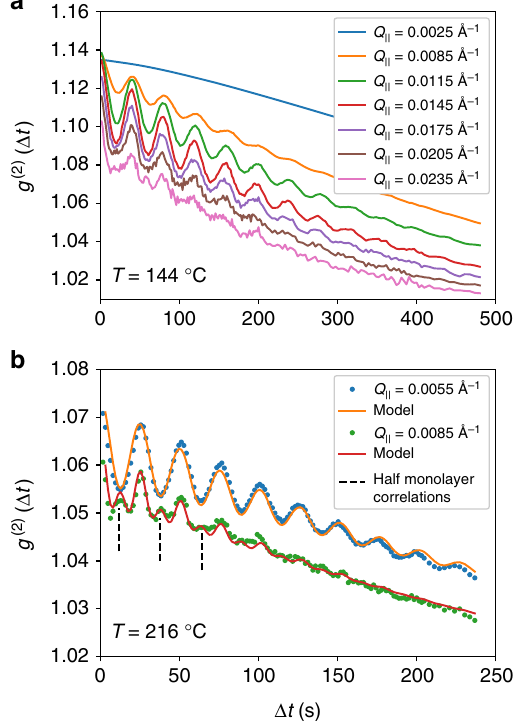
Fig. 3 Autocorrelations during steady-state deposition. a Growth at 144 °C as a function of Q || , with fi xed Q z = 0.045 Å − 1 . Note that the oscillation frequency is independent of Q || . The step spacing can be estimated from 2 π / Q max , where Q max is the in-plane component of the wave-vector transfer at which g (2) has the maximum oscillation amplitude. b Growth at 216 °C for two different Q || . The shape of the autocorrelation curve changes at large Q || , where the maxima become sharp and the minima become broadened. A half-monolayer correlation is observed, which is indicated by dashed lines. An empirical model to fi t the data is described in the main text. Note that the upper curve in b is offset by 0.01 for the sake of clarity